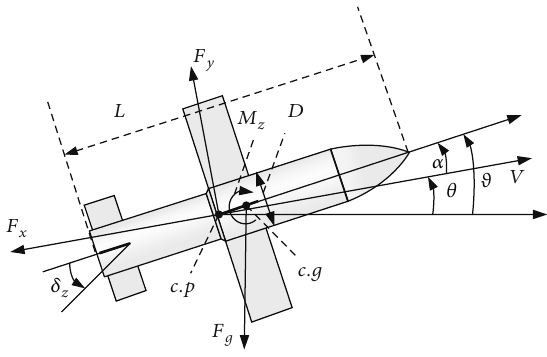
Figure 1: Missile model and characteristic